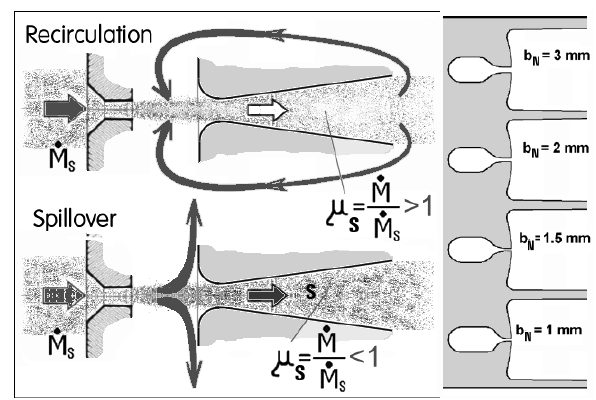
Fig. 13. In the absence of solid mechanical blockage in pure fluidics, it depends on the loading whether there will be jet pumping or spillover – or, mostly desired, neither of these two = the no-spillover regime. The study in [17] used a family of nozzles (right) with equal depth and different exit widths.